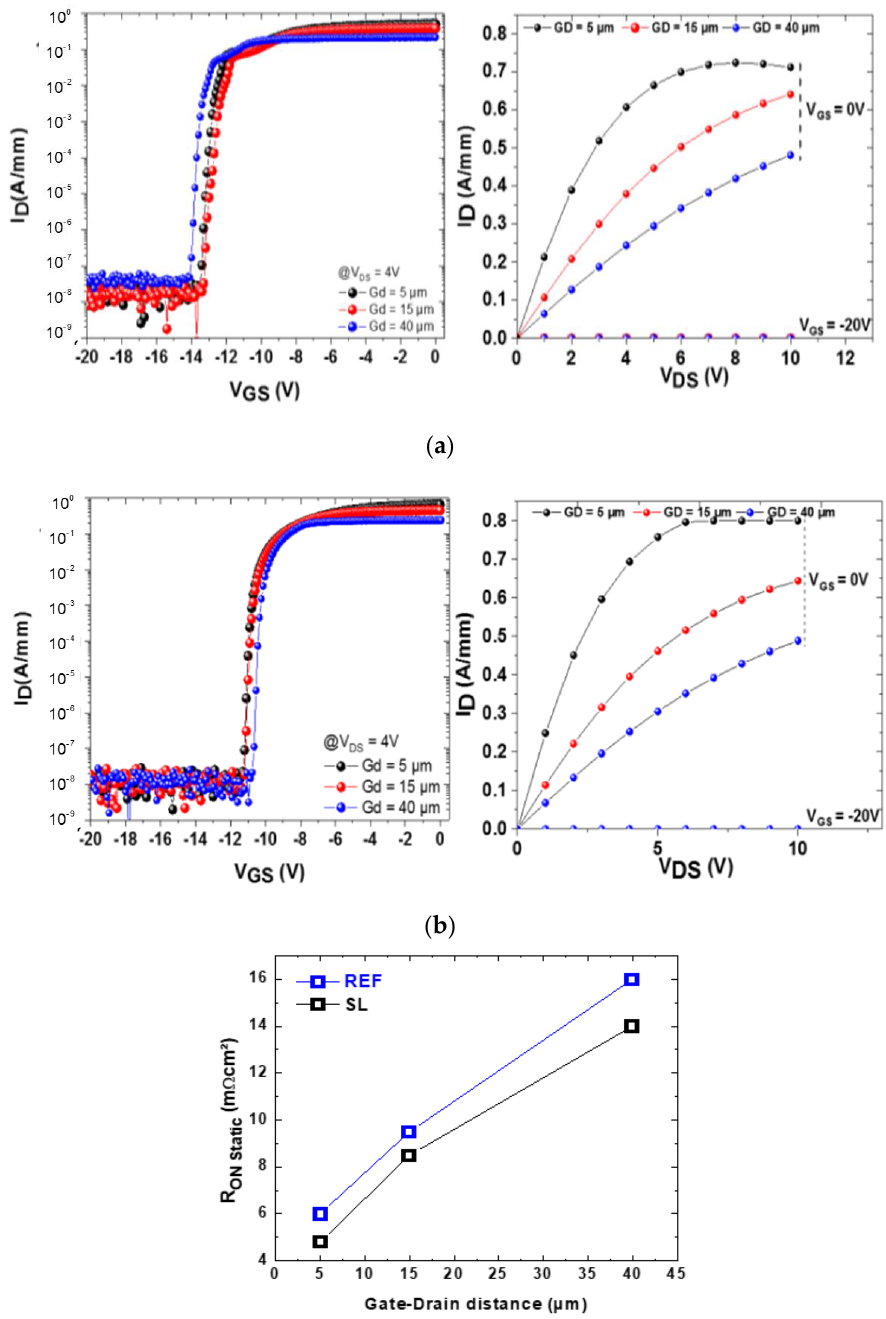
Figure 6. ( a ) Typical I-V characteristics for various gate-drain distances for REF structures. ( b ) Typical I-V characteristics for various gate-drain distances for SL structures. ( c ) On resistance for the SL and reference structure at different gate drain distance.